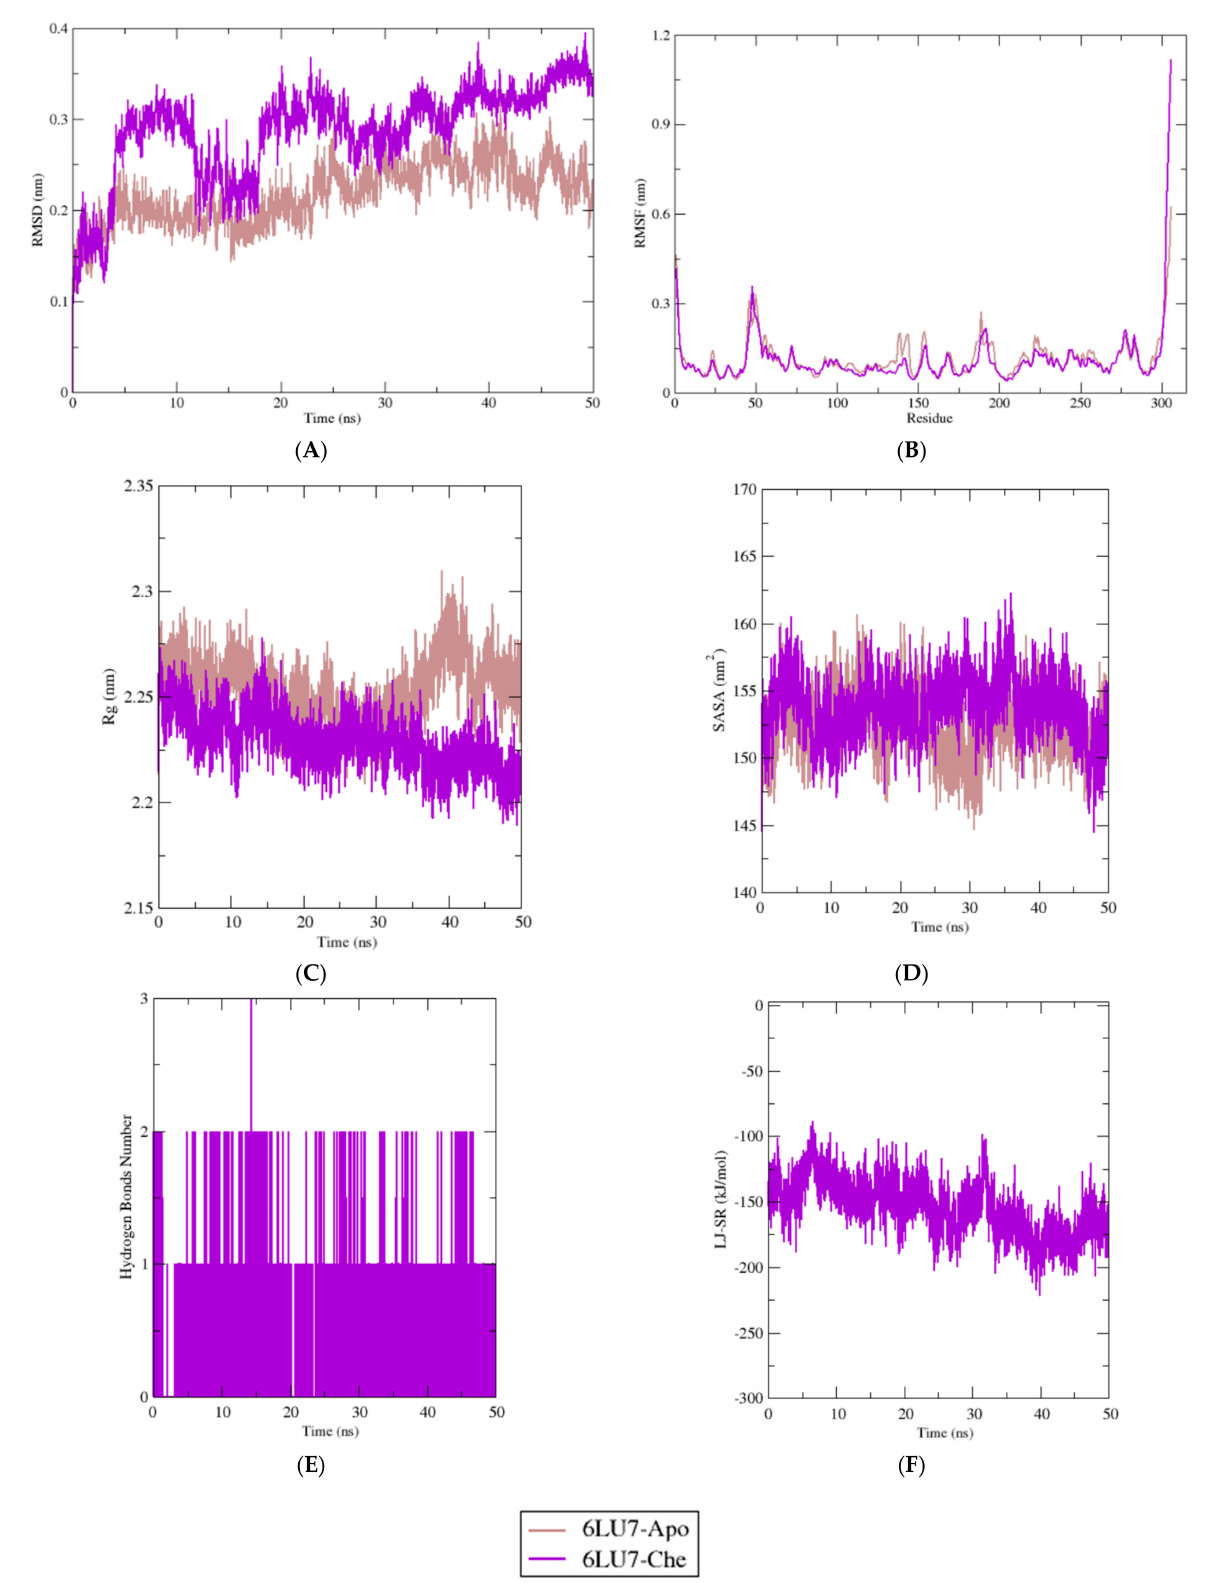
Figure 3. ( A ) Root-mean-square deviation (RMSD), ( B ) root-mean-square fluctuation (RMSF), ( C ) radius of gyration (Rg), ( D ) solvent accessible surface area (SASA), ( E ) intermolecular hydrogen bonds number, ( F ) short-range Lennard- Jones protein-ligand interaction energy analysis of the apo form (6LU7-Apo) and chelidimerine (6LU7-Che) holo form of SARS-CoV-2 M pro throughout 50